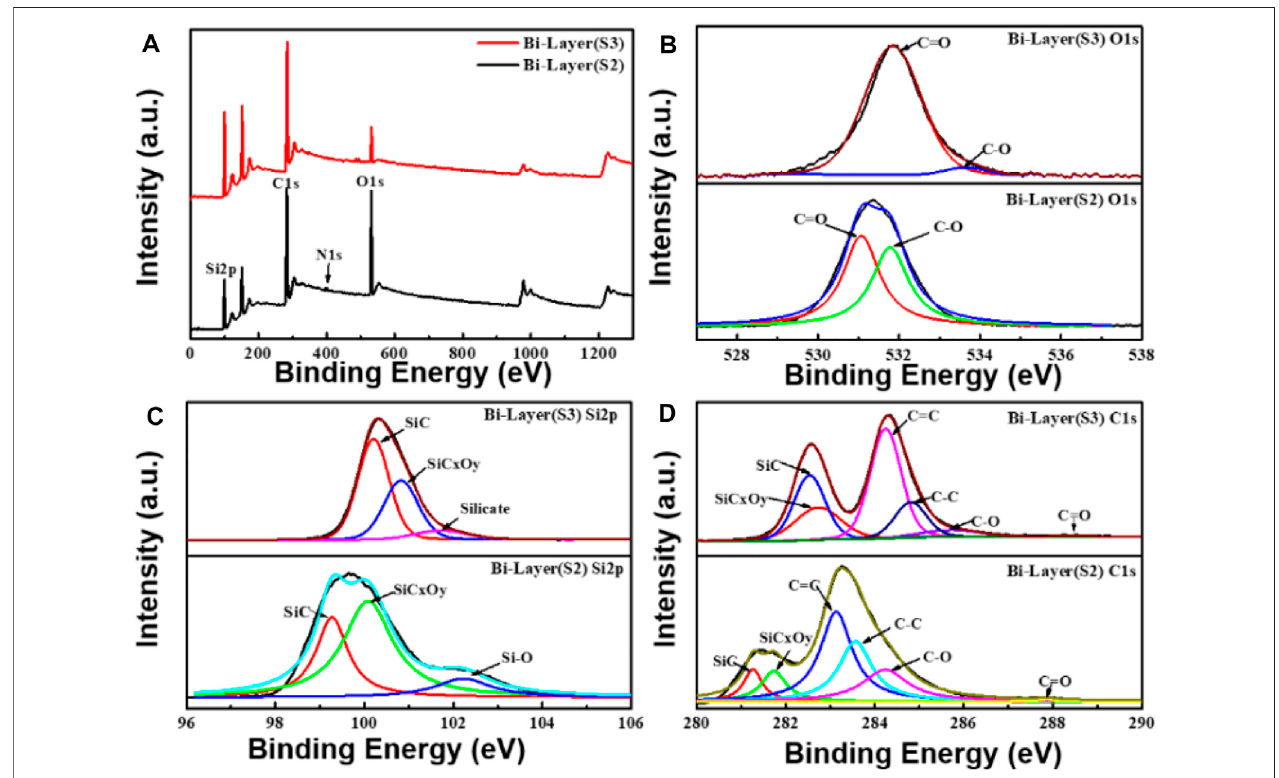
FIGURE 2 | XPS electron spectra of the two types of bilayer graphene that were prepared by the substrate transfer method and the SiC pyrolysis method, respectively. (A) XPS spectra of bilayer graphene prepared by the two methods. (B – D) Spectra of O1s, Si2p, and C1s elements of the substrate-transferred bilayer graphene (S2) and SiC pyrolysis bilayer graphene (S3), respectively.